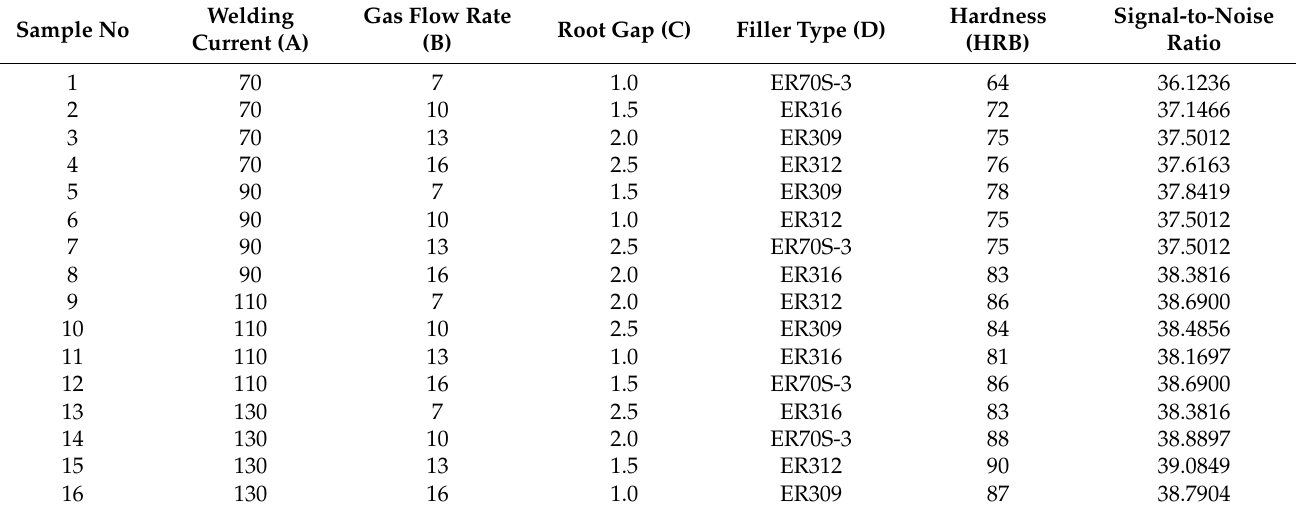
Table 11. Mean hardness testing result.